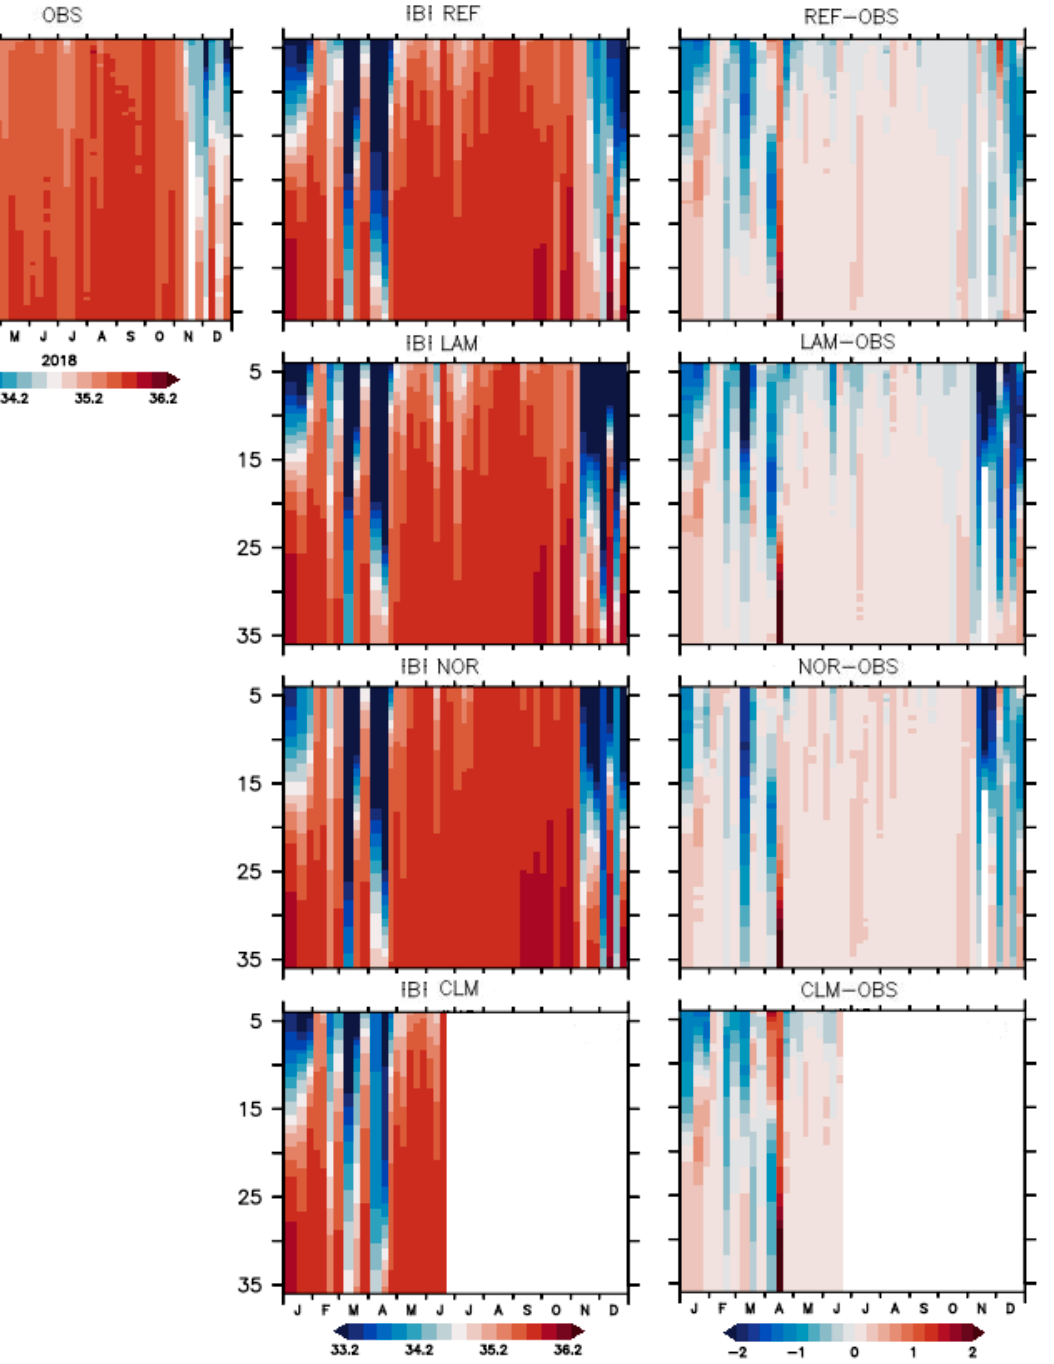
Figure 10. Salinity profiles measured by CTD at the INTECMAR station C3 (8.96 ◦ W/42.48 ◦ N) for 2018 in WISHE area ( left panel) in comparison with salinity profiles simulated, at the closest model grid point, by the different model scenarios— IBI_REF, IBI_LAM, IBI_NOR and IBI_CLM ( middle panel). Differences between modelled and observed salinity profiles ( right panels). Note that IBI_CLM run is shorter than other simulations.